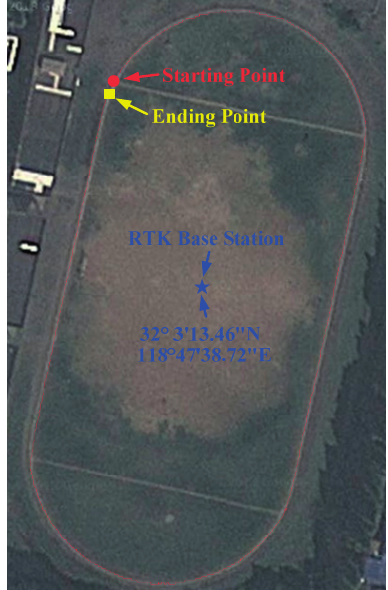
Figure 10. Trajectory of the cart obtained the RTK.